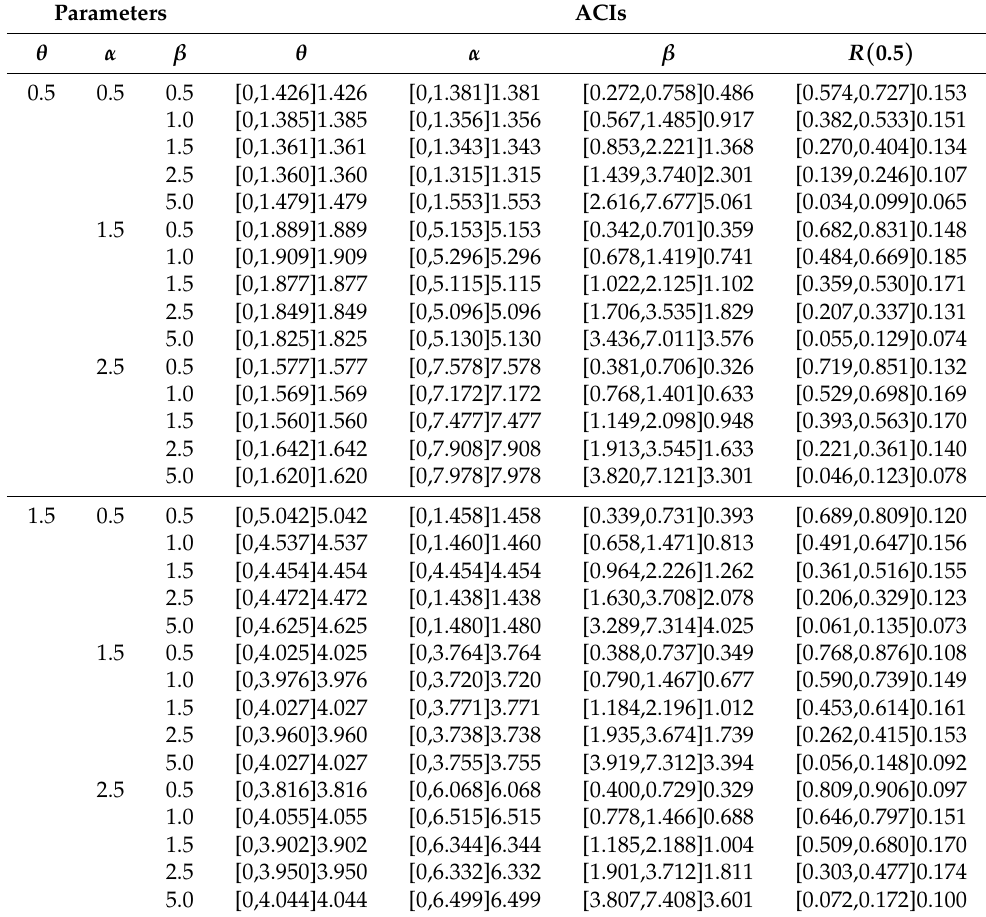
Table 6. The AVs of CIBs (in parentheses) and the corresponding CILs for n = 100. Parameters